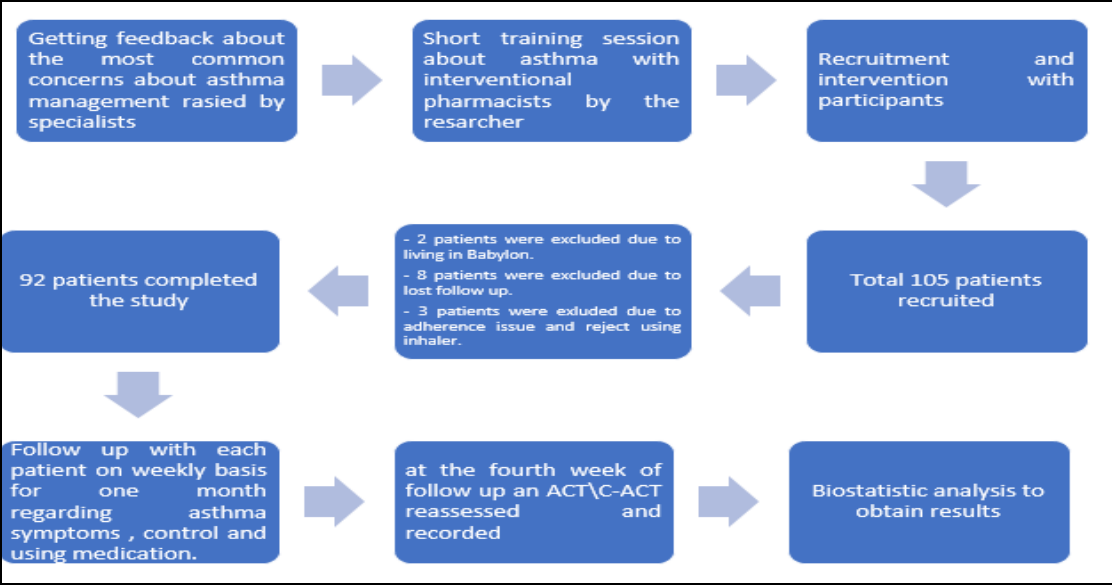
Figure 1. The flowchart of the study